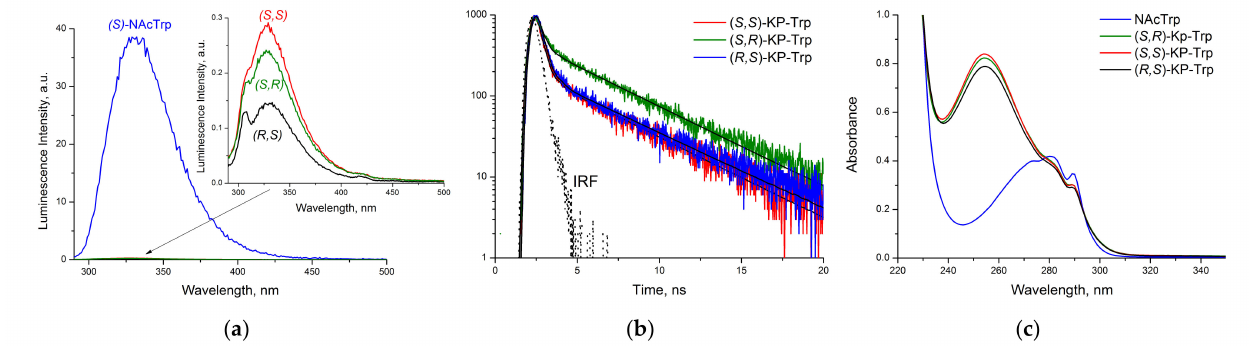
Figure 3. ( a ) Fluorescence spectra of is isoabsorptive solutions of (S) -NAcTrp and (S,S) -, (S,R) -, and (R,S) -optical isomers of KP-Trp dyad in acetonitrile ( λ ex = 280 nm) in 1 cm cuvette. Concentrations were about 6 × 10 − 5 M; ( b ) Fluorescence decay traces of ( S,S )-, ( S,R )-, ( R,S )-optical isomers of KP-Trp dyad in acetonitrile at 330 nm ( λ ex = 270 nm), Instrument response function (IRF); ( c ) absorbance spectra of ( S )-NAcTrp and ( S,S )-, ( S,R )-, and ( R,S )-optical isomers of KP-Trp dyad in acetonitrile in 1 cm cuvette.